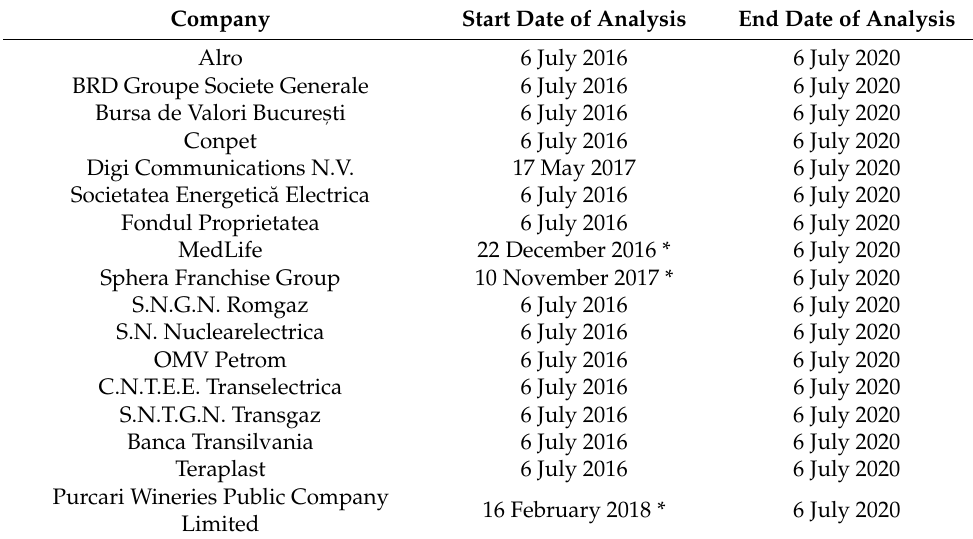
Table A1. Romanian companies considered in the analysis, components of BET